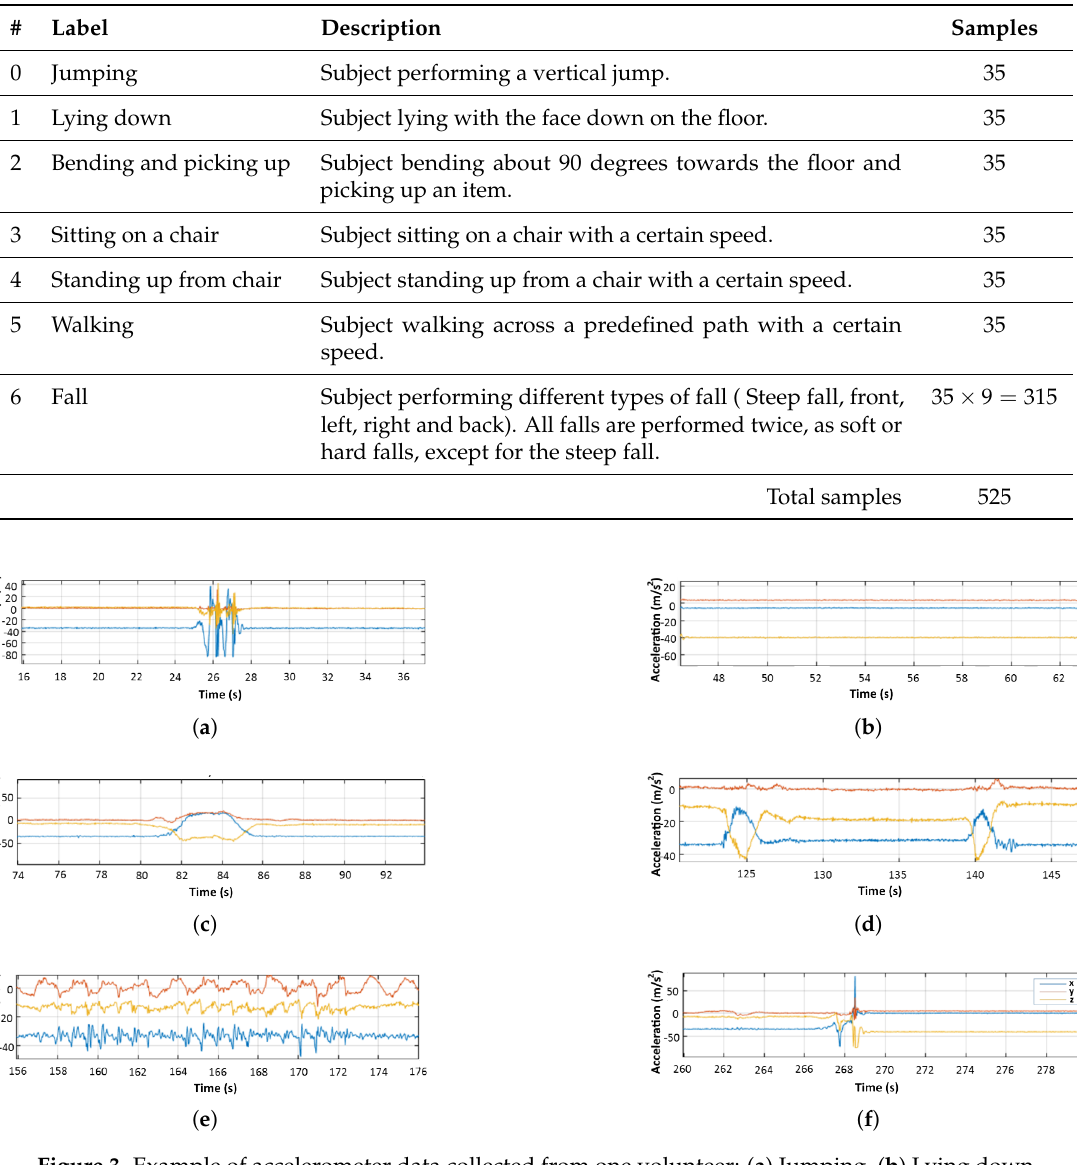
Figure 3. Example of accelerometer data collected from one volunteer: ( a ) Jumping, ( b ) Lying down, ( c ) Bending and picking up, ( d ) Sitting down/standing up, ( e ) Walking, and ( f )